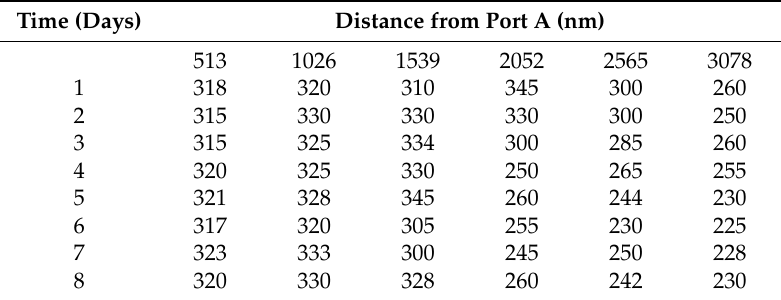
Table A6. Wind direction in degrees ( ◦ ) with respect to north, counting counterclockwise, as a function of time and space for all